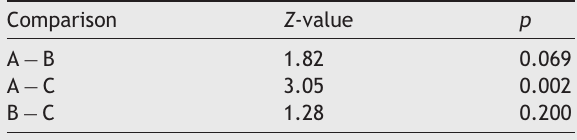
Result of multiple comparisons of the degree of inflammation in the induced side between the groups.